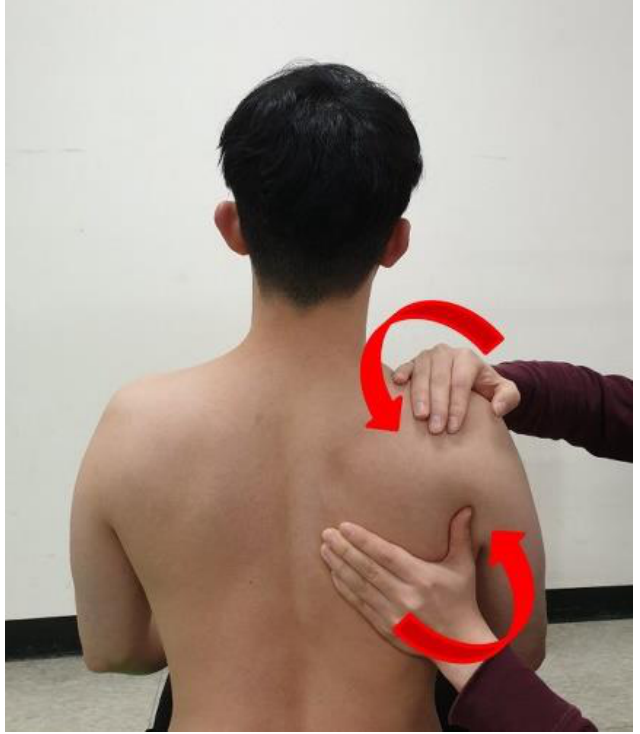
Figure 3. Guidance of scapular posterior tilt movement for the intended scapular posterior tilt training.